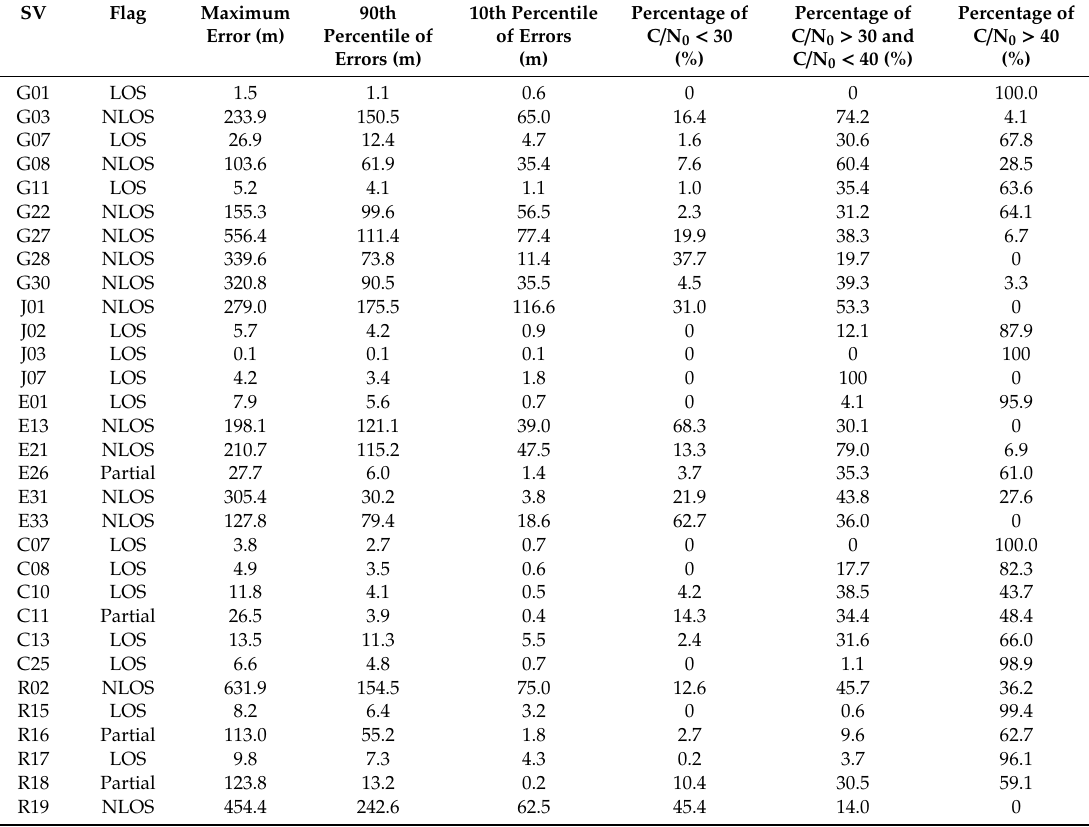
Table 1. Statistics of pseudo-range errors and C / N